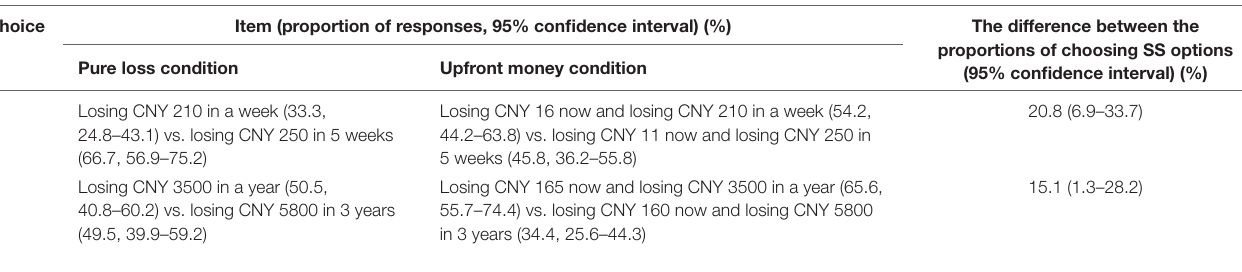
TABLE 2 | Questionnaire items and summary of the choice results for Experiment 2. Choice Item (proportion of responses, 95% confidence interval) (%) The difference between the